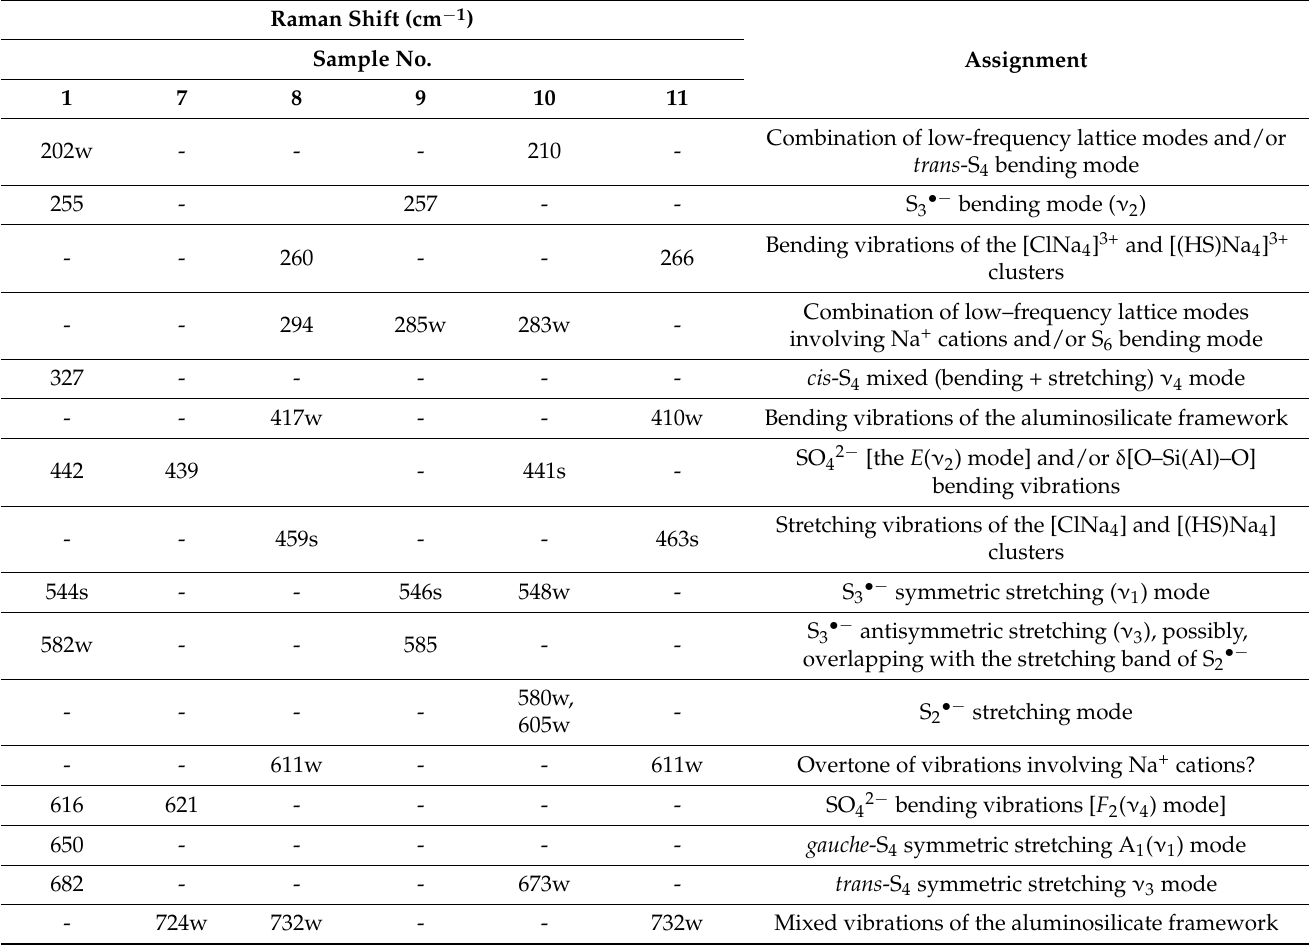
Table 2. Assignment of Raman bands of cubic sodalite-group minerals.